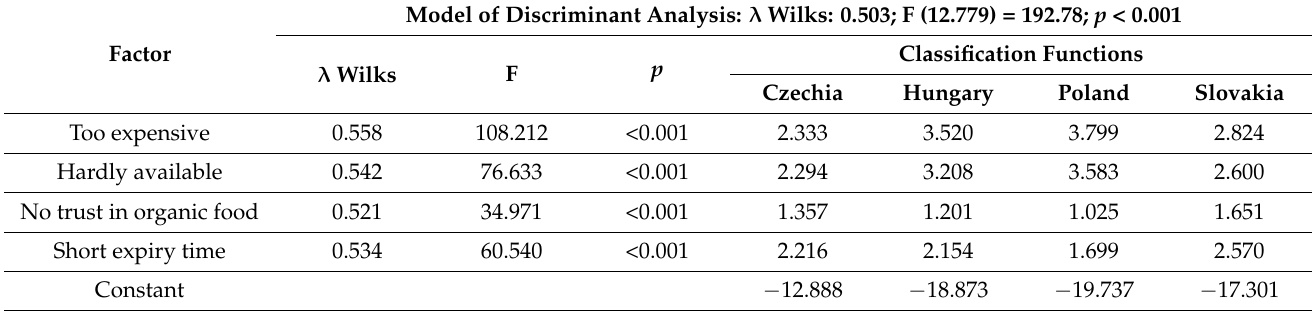
Table 4. Barriers to purchasing organic food depending on the